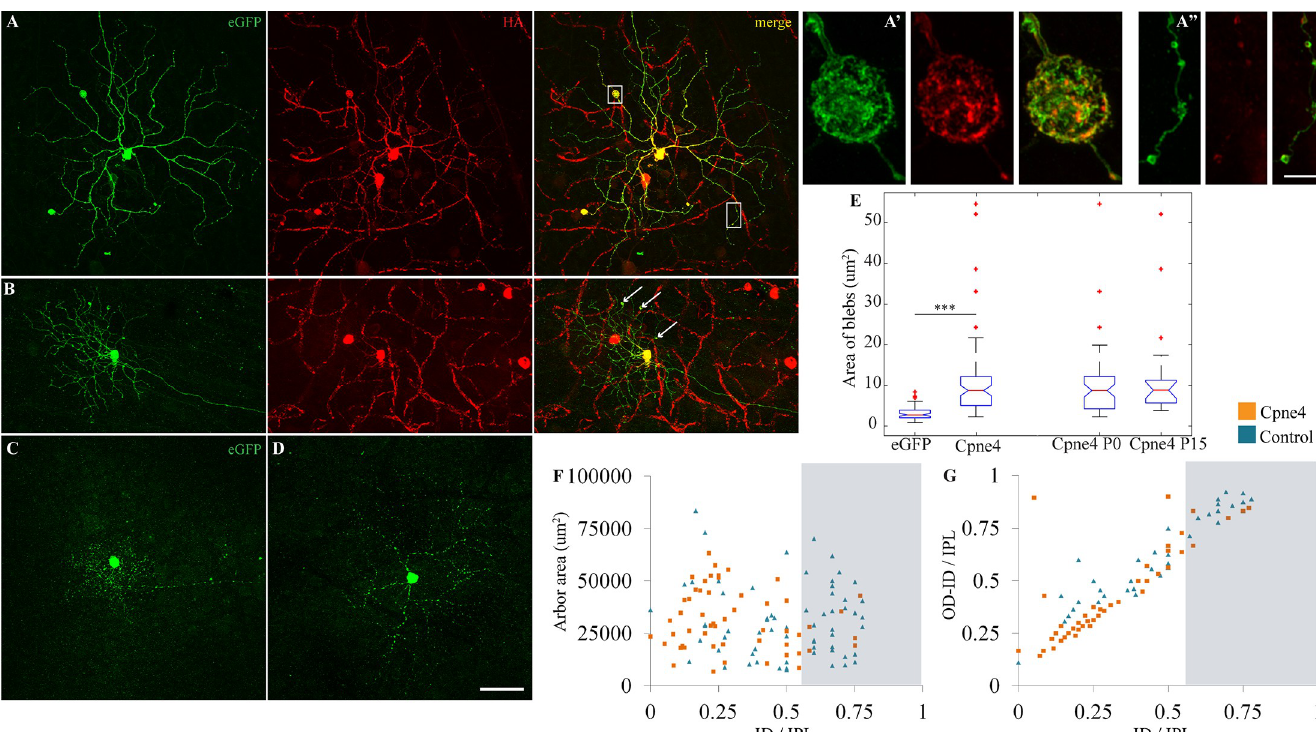
Fig 2. Cpne4 virus infections lead to ‘bleb’ formation on dendrites of Brn3b+ RGCs. (A, B) Intraocular injections of AAV1-Cpne4 viruses were done in P0 or P14 Brn3b Cre/WT mice eyes. Blebs (indicated by boxes and arrows ) were seen occasionally on dendrites of Cpne4 infected RGCs. For controls, AAV1-eGFP was similarly injected in P0 Brn3b Cre/WT mice (C, D). No blebs were observed in the control infected RGCs. Airy scan images for one of the blebs (A’) and adjoining dendrites (A”). (E) Measurement of the ‘bleb’ areas for Cpne4 infected RGCs as compared to regular varicosities on controls shows a significant difference between them while no difference between P0 and P15 Cpne4 infected retinas. (F, G) Areas and lamination measurements indicate no differences between the Cpne4 transfected RGCs as compared to control transfected RGCs. (ID and OD: Inner and outer distance- distance between innermost or outermost tip of RGC dendrites and the INL; IPL: Width of the IPL). Scale bar for A-C: 50 μ m; Scale bar for A’, A”: 5 μ m. ��� , p <